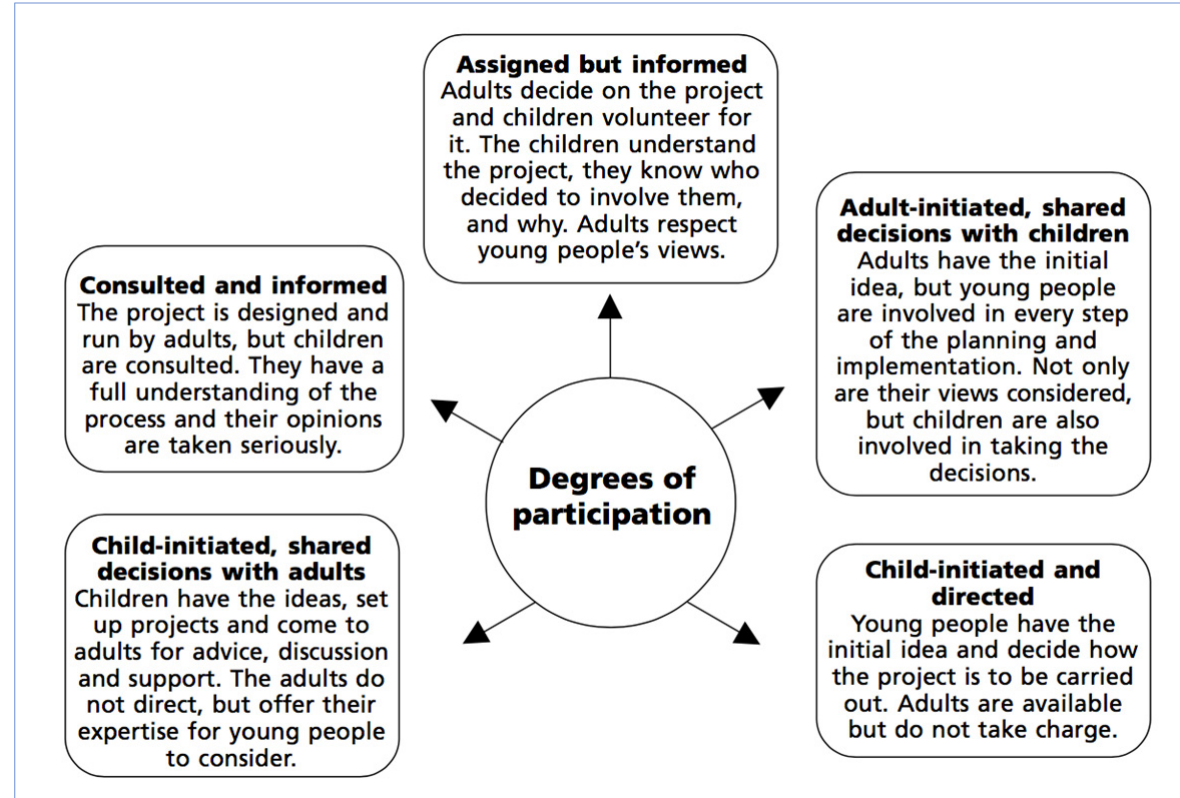
Figure 2. Treseder’s (1997) Degrees of Participation (Save the